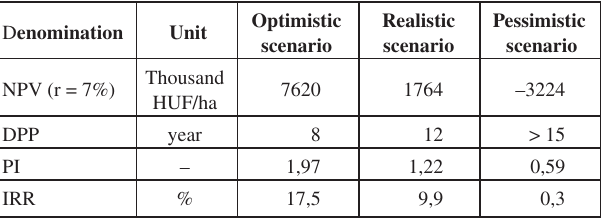
Table 7. Investment Efficiency in German Apple Production without Investment Subsidies D